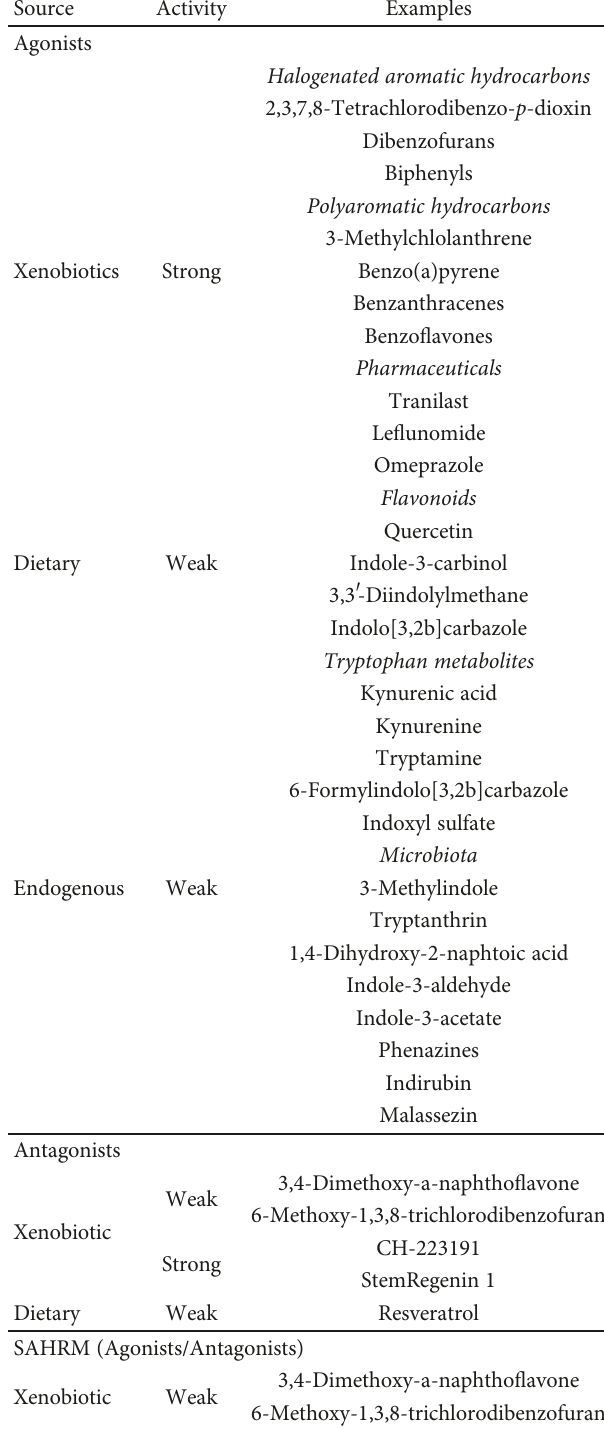
Table 1: List of major ligands of aryl hydrocarbon